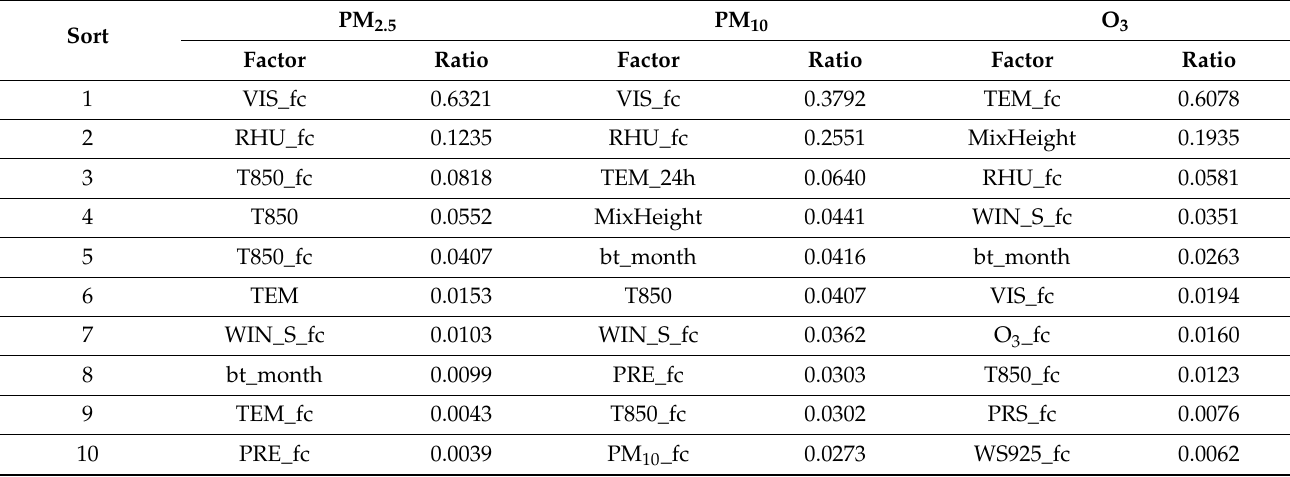
Table A1. Correction factor filtering